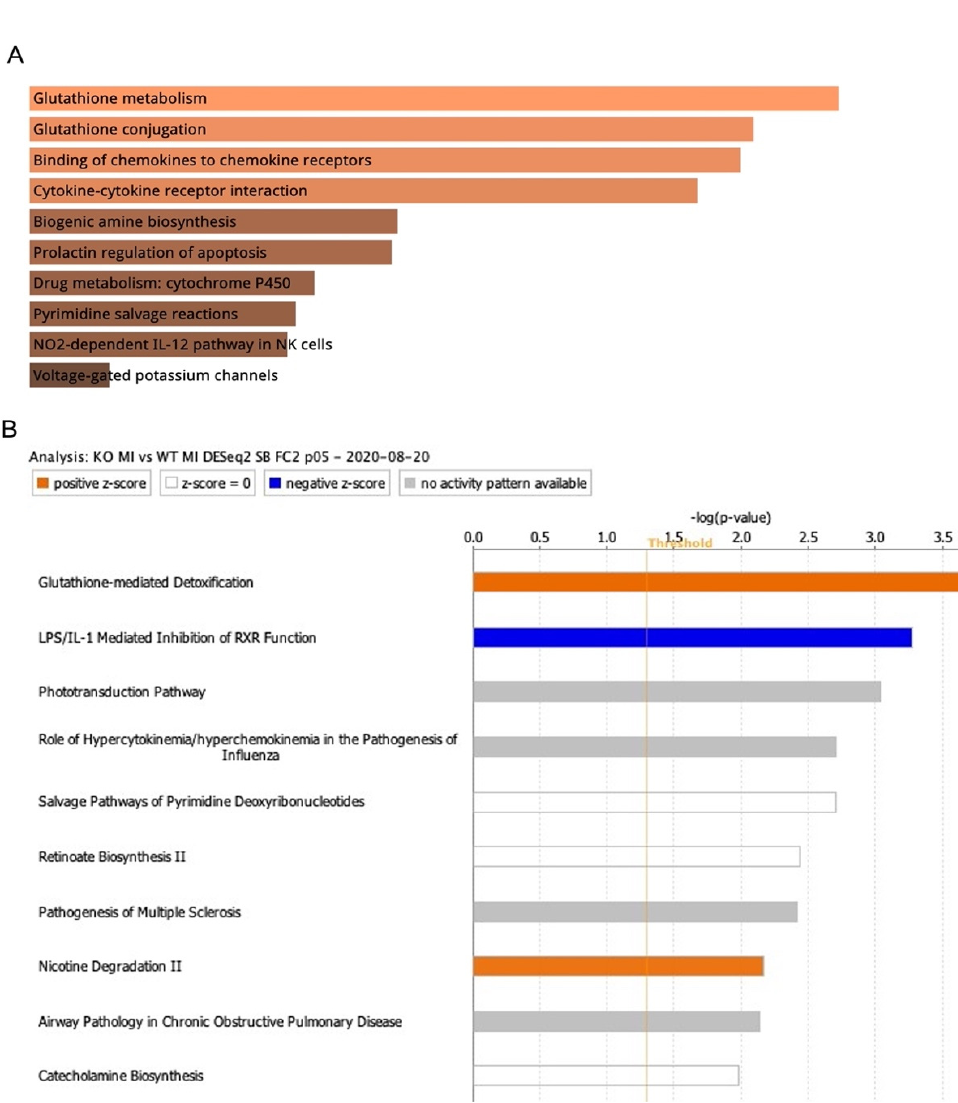
Figure 7. Glutathione metabolism pathway modulation following IR is accentuated in response to FtH deficiency. KEGG analyses of RNA-sequencing data showing the top 10 enriched pathways using ( A ) Enrichr platform and ( B ) Ingenuity pathways analysis platform between FtH fl/fl and FtH SM22 ∆ / ∆ samples. Both analyses identify the glutathione metabolism pathway as the top canonical pathway differently modulated between genotypes in response to IR. n = 3/group.